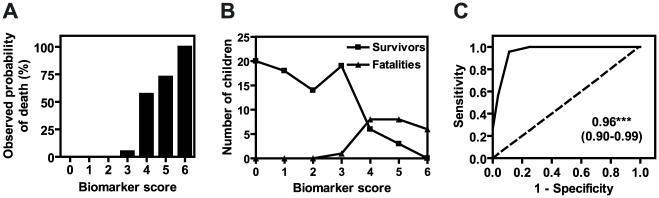
The biomarker score is significantly associated with risk of fatality among children with severe malaria.The biomarker score for each patient was calculated as detailed in the text. (A) Biomarker scores were plotted against observed probability of death. The two variables were significantly related (Spearman's rho = 0.96, p = 0.003). (B) Biomarker score distributions were plotted for severe malaria survivors and fatalities. (C) A receiver operating characteristic (ROC) curve was generated for the biomarker score. The dashed reference line represents the ROC curve for a test with no discriminatory ability. Area under the ROC curve is displayed on each graph with 95% confidence intervals in parentheses. *** p<0.001.